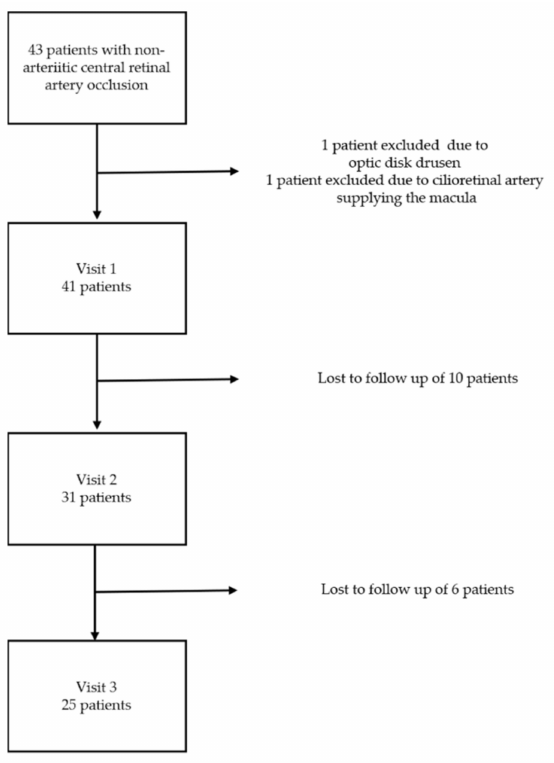
Figure 1. Flow-diagram of the study design. Twenty-seven (65.9%) patients were male and 14 (34.1%) female. The left eye was affected in 18 (43.9%) patients, and in 23 (56.1%) the right eye. A spot sign was diagnosed in 24 (58.5%) patients (Figure